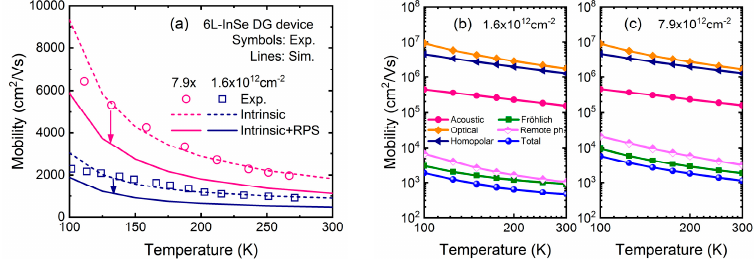
Figure 2. Temperature-dependent mobility in six-layer InSe FETs at inversion density of 1.6 × 10 12 cm − 2 and 7.9 × 10 12 cm − 2 , respectively. ( a ) Comparison between the experimental mobility (symbols) and calculated intrinsic mobility without remote phonon scattering (RPS) (dashed lines), which shows an excellent agreement. In contrast, the mobility with RPS (solid lines) is significantly degraded. ( b , c ) Contributions of each scattering mechanisms to the total mobility for different inversion density respectively. Intrinsic scatterings include acoustic (AC), optical (OP), and homopolar (HO) phonon scatterings as well as Fröhlich interaction, while extrinsic scattering is remote phonon scattering arising from the HfO 2 high- κ dielectric.